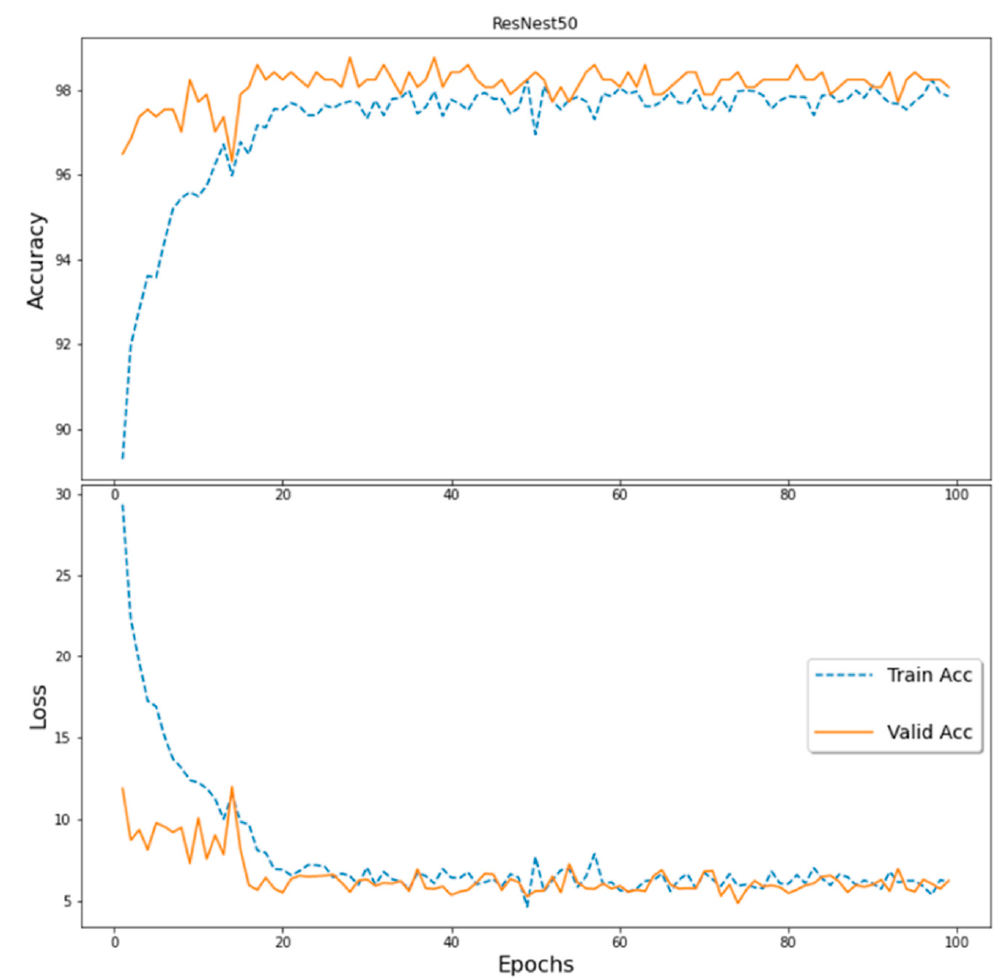
Figure 8. Accuracy and loss of the ResNest50 during training and validation. An image was randomly selected from the test data set (clipping completed), and the model operation was carried out. The infected image blocks in the calculation results were given different colors according to their severity, and then, they were spliced together for display. A blue box represents a slight silver window, while a red box represents an irregular wormhole (see Figure